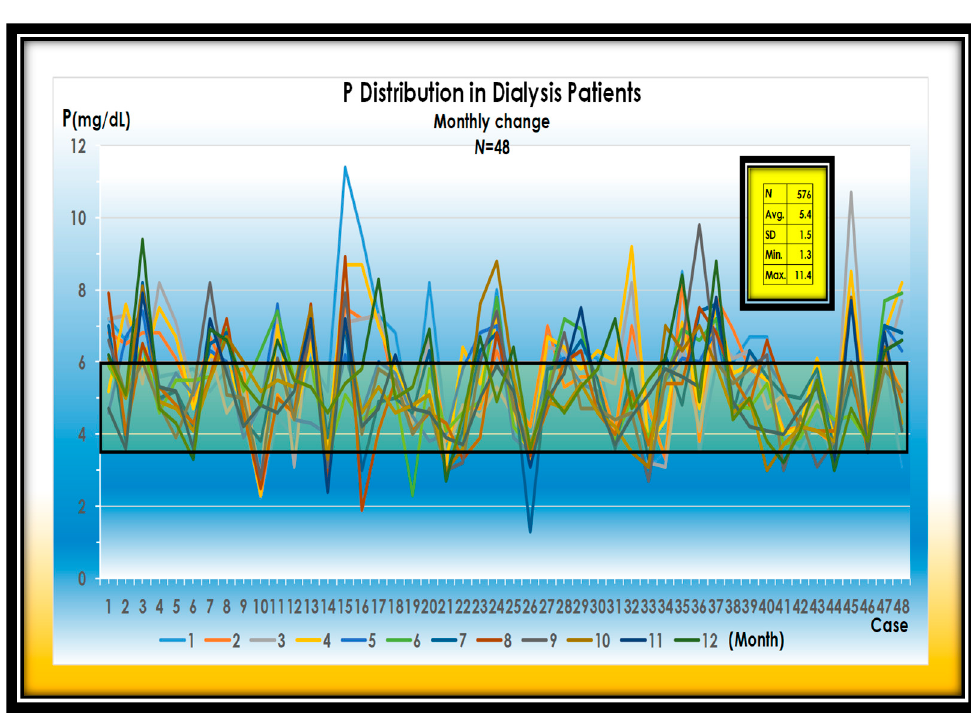
Figure 1. Changes in serum P levels in 48 dialysis patients. Average of P is 5.4 mg. SD is 1.5 mg/dL. Maximum of P is 11.4 mg/dL.